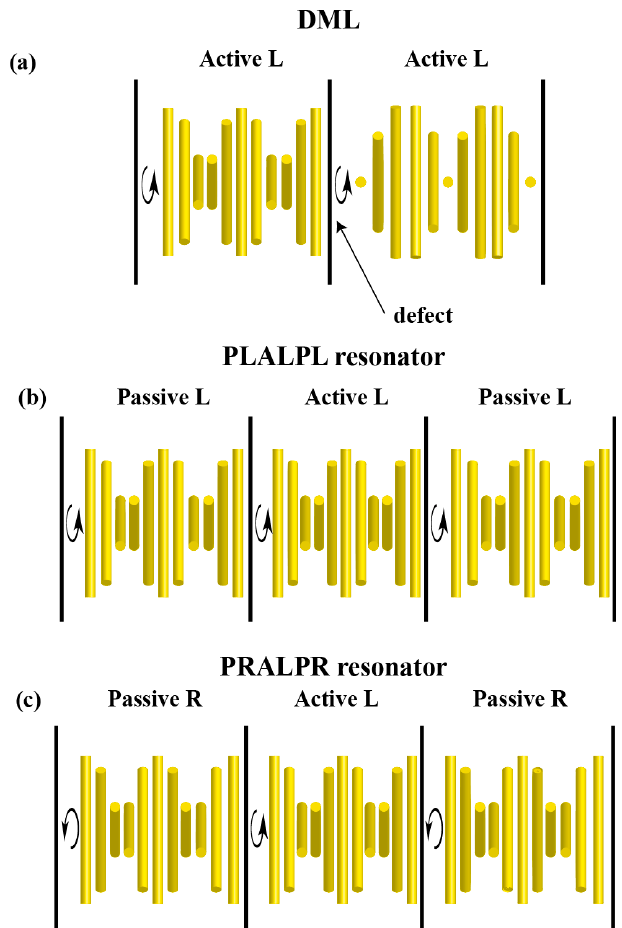
Figure 1. Schematic representation of different cell architectures. ( a ) Bilayer CLC (cholesteric liquid crystals) cell with a defect consisting in a jump of π /2 in the twisting angle; ( b , c ) are complex CLC structures with a dye-doped layer sandwiched between two passive layers acting as mirrors. In ( b ) the whole structure presents the same handedness, i.e., L—left, whereas in ( c ), the external films have opposite handedness, i.e., R—right, to that of the active film. The setups are labeled as DML (defect mode laser) ( a ), PLALPL (passive left handed layer-active left handed layer-passive left handed layer) resonator ( b ), and PRALPR (passive right handed layer-active left handed layer-passive right handed layer) resonator ( c ).